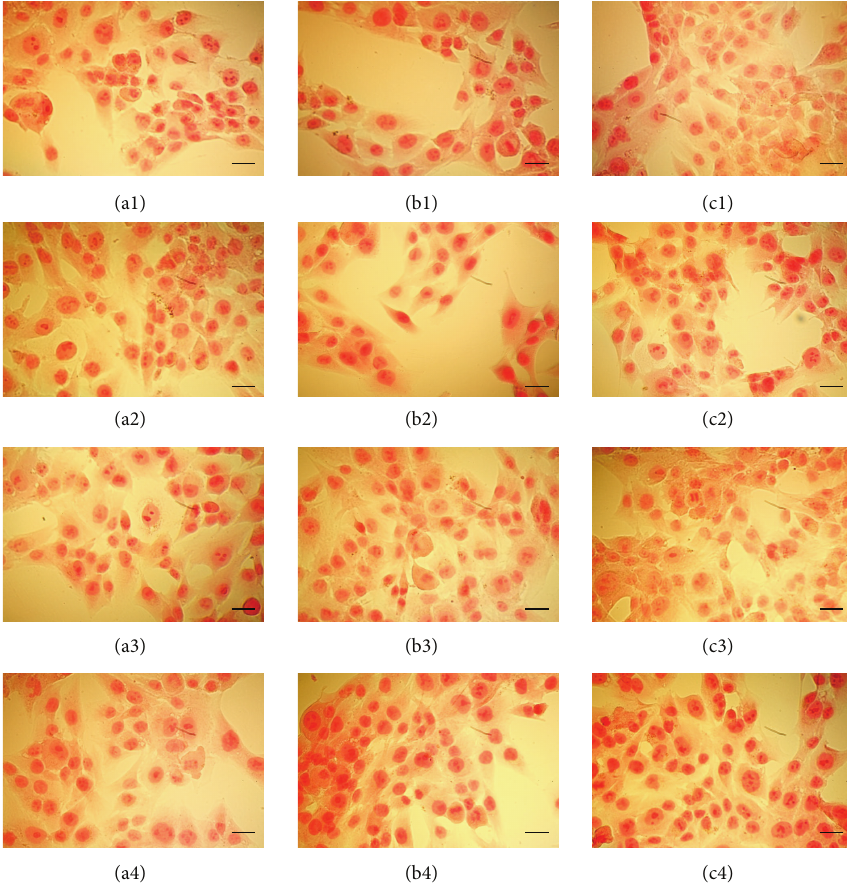
Figure 4: Pictures were taken under optical microscopy of the cells treated for 24 h with different NSAIDs ((1) dexketoprofen; (2) ketorolac; (3) metamizole; (4) acetylsalicylic acid) at different doses ((a) control; (b) 1 𝜇 M; (c) 10 𝜇 M) in osteogenic medium and dyed with Sirius red for to see the synthesis of collagen fibrins. Bars = 50 𝜇